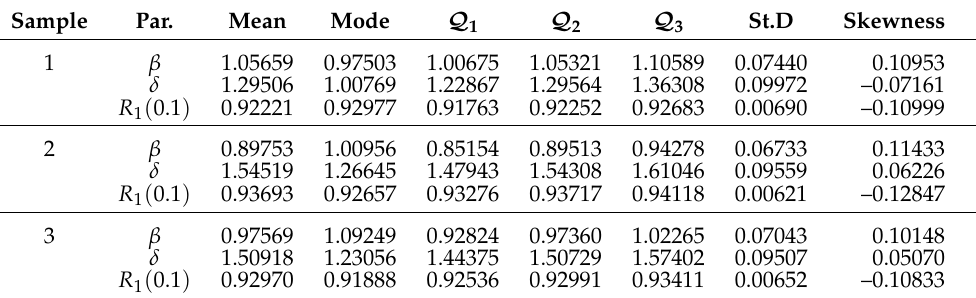
Table 11. Characteristics of β , δ and R 1 ( t ) from LED data.